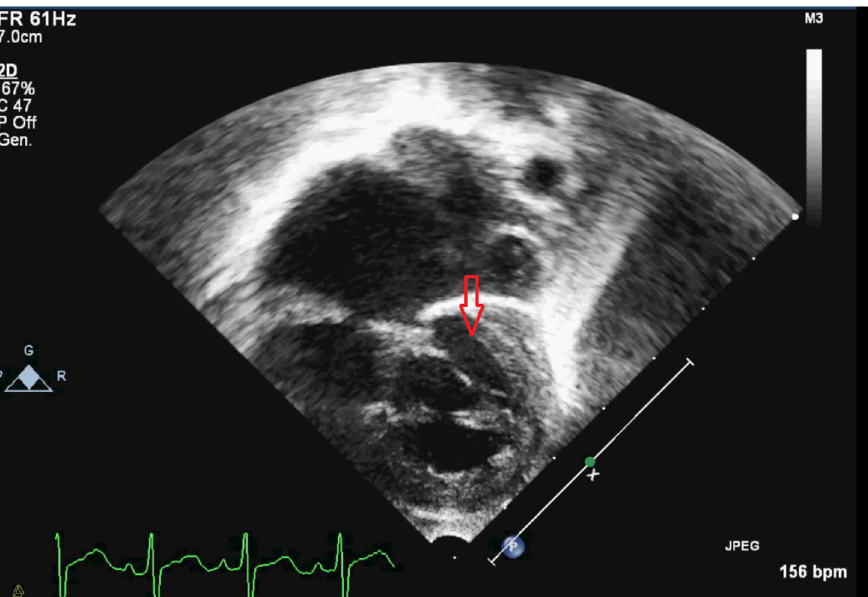
Figure 1. Apical four chambers view showing the left “slit like” ventricle and the atresia of the mitral valve plane. The arrow points at the left ventricle. valve plane. The arrow points at the left ventricle. Table 1. Patient Features. Table 1. Patient